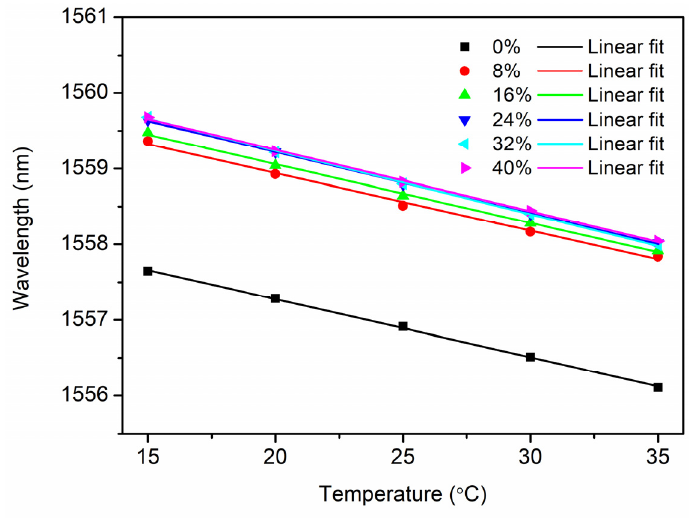
Figure 5. Linear fit of Bragg wavelength versus temperature in the temperature decrease process for soils with different SMCs (0%, 8%, 16%, 24%, 32% and 40%) with sensitivities ( − 0.077 nm/ ◦ C,